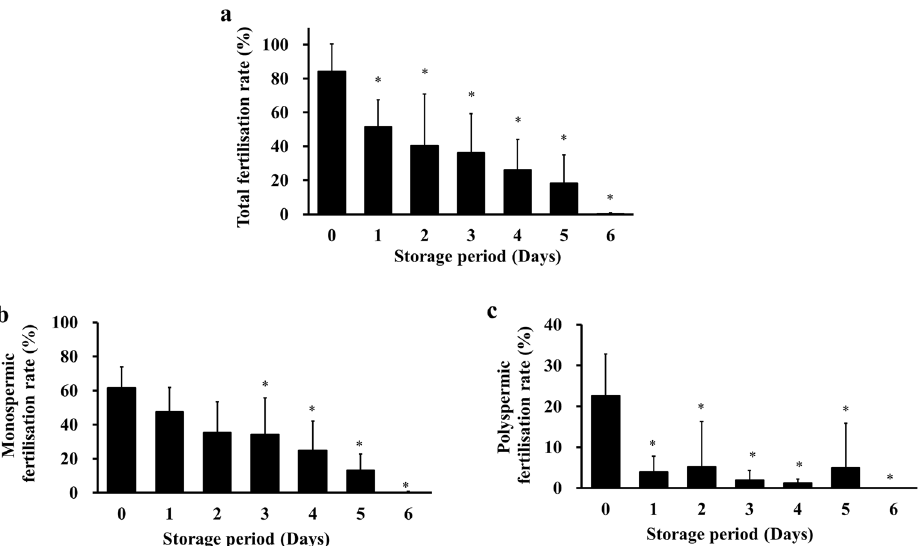
Figure 4. Effect of storage period on the fertilisation ability of cold-stored sperm. Cauda epididymides were cold-stored in Lifor containing 15% DMSO and 200 µg/mL quercetin at 4 °C for 0–6 days. After cold-storage, sperm were cultured in mHTF and cumulus-oocytes complexes collected from a female rat were introduced into the sperm suspension. The total fertilisation rate was calculated as the number of fertilised oocytes divided by the total number of oocytes and multiplied by 100 ( a ). The monospermic fertilisation rate was calculated as the number of monospermic oocytes (two pronuclei and a sperm tail or a sperm tail in the cytoplasm) divided by the total number of oocytes and multiplied by 100 ( b ). The polyspermic fertilisation rate was calculated as the number of polyspermic oocytes (more than three pronuclei and more than two sperm tails or more than two sperm tails in the cytoplasm) divided by the total number of oocytes and multiplied by 100 ( c ). Results are expressed as mean ± SD (n = 4–8 male rats/group, 46 female rats and 46 male rats were used). * P < 0.05 compared with day